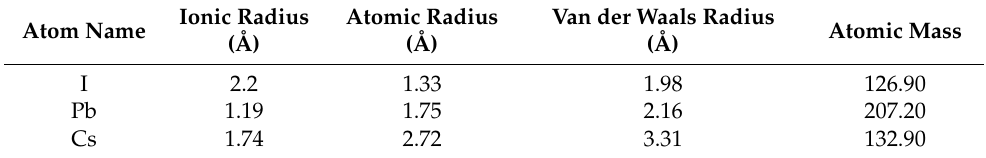
Figure 4. Two-dimensional (2D) and 3D depiction of electron density of the pure inorganic perovskite: ( a ) CsPbI 3 − Cubic, ( b ) CsPbI 3 − Orthorhombic. Table 2. Ionic radii, atomic radii, Van Der Waals radii, and atomic masses of I, Pb, and Cs.